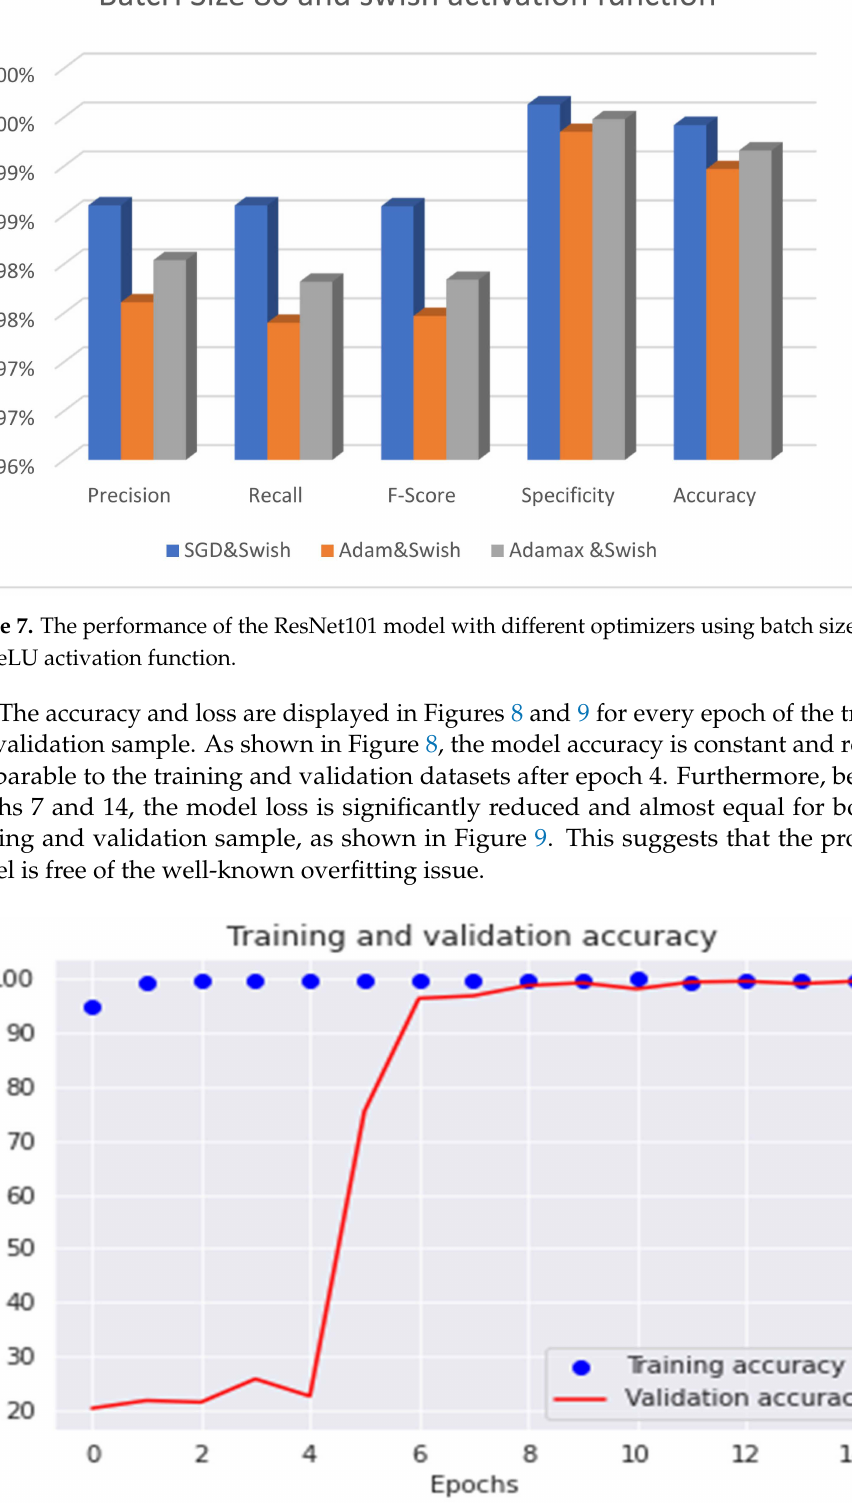
Figure 8. The ResNet101 model accuracy vs. epoch